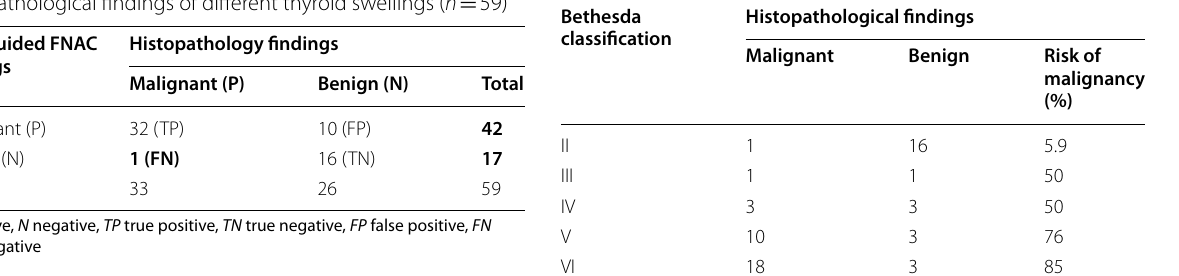
Table 1 Cross-tabulation of guided FNAC findings with histopathological findings of different thyroid swellings ( n USG-guided FNAC findings